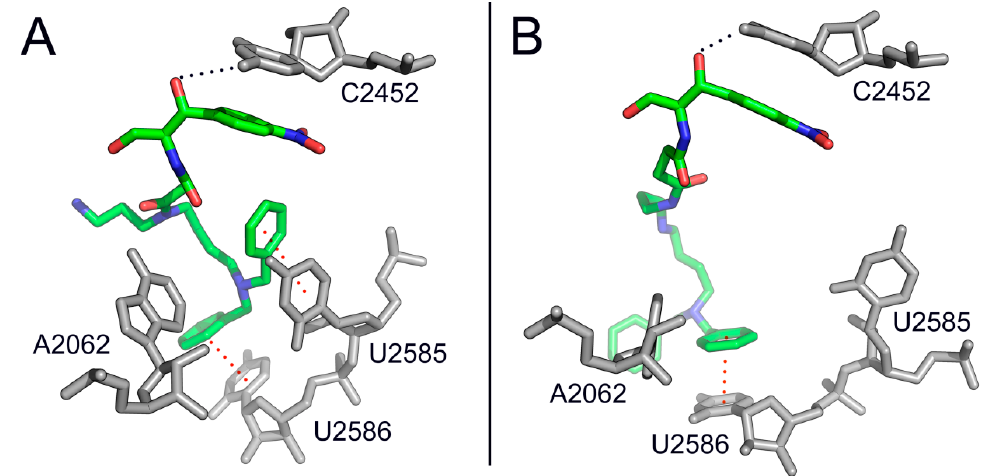
Figure 10. Binding positions of compounds 34 and 35 in the Escherichia coli ribosome, as detected by kinetic analysis, footprinting assays, and MD simulations [73]. ( A ) Compound 34 (in green) binds to the ribosomal A-site through its CAM scaffold, while the dibenzyl-PA tail makes π -stacking interactions with nucleotides U2585 and U2586 of 23S Rrna; ( B ) Compound 35 (in green) exhibits a similar pattern of interactions with the A-site but the dibenzyl-PA tail stacks only on U2586, thus behaving as a weaker inhibitor of peptide-bond formation.